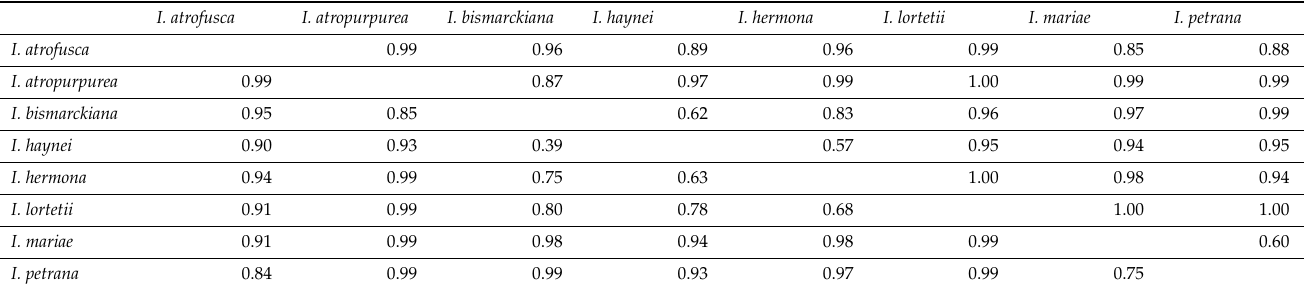
Table 2. Reproductive isolation (RI) values among eight Israeli Iris species. Above the diagonal—RI values calculated with phenology data from net-house (common garden); Below the diagonal—RI values calculated with phenology data from wild populations (see METHODS).